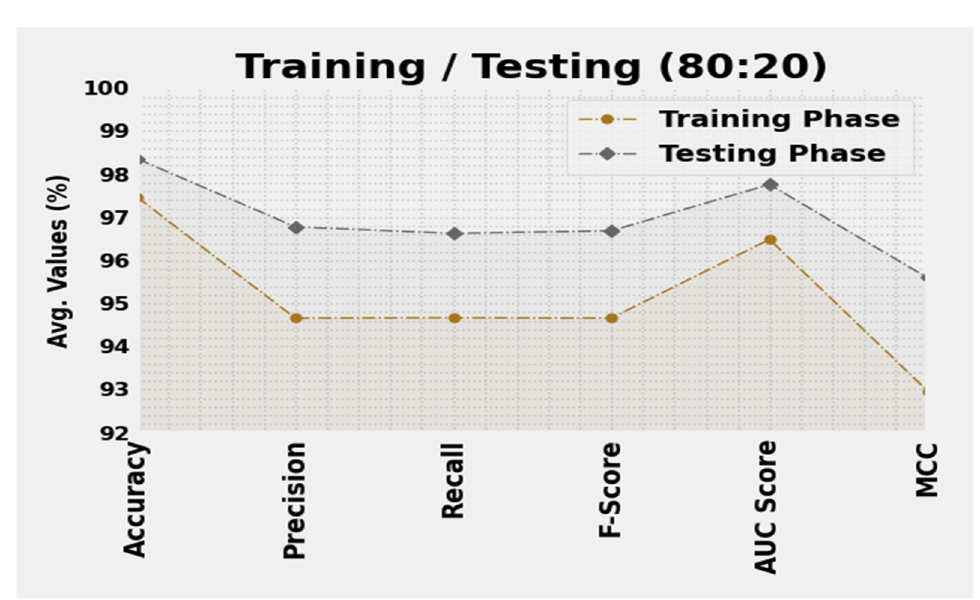
Figure 5. Average outcome of TSADL-LULCCD method on 80:20 of TR/TS databases. On the TR database, the TSADL-LULCCD technique has recognized grassland samples with accu y of 98.12%, prec n of 95.65%, reca l of 98.51%, F score of 97.06%, AUC score of 98.23%, and MCC of 95.70%. In the meantime, the TSADL-LULCCD approach has identified agriculture samples with accu y of 98.59%, prec n of 95.56%, reca l of 97.73%, F score of 96.63%, AUC score of 98.27%, and MCC of 95.75%. Furthermore, the TSADL-LULCCD method has categorized barren land samples with accu y of 98.59%, prec n of 97.73%, reca l of 95.56%, F score of 96.63%, AUC score of 97.48%, and MCC of 95.75%. The TACC and VACC of the TSADL-LULCCD approach are inspected on 80:20 of TR/TS databases in Figure 6. The outcomes implied that the TSADL-LULCCD methodology had shown improved performance with increased values of TACC and VACC. Notably, the TSADL-LULCCD method has reached maximum TACC